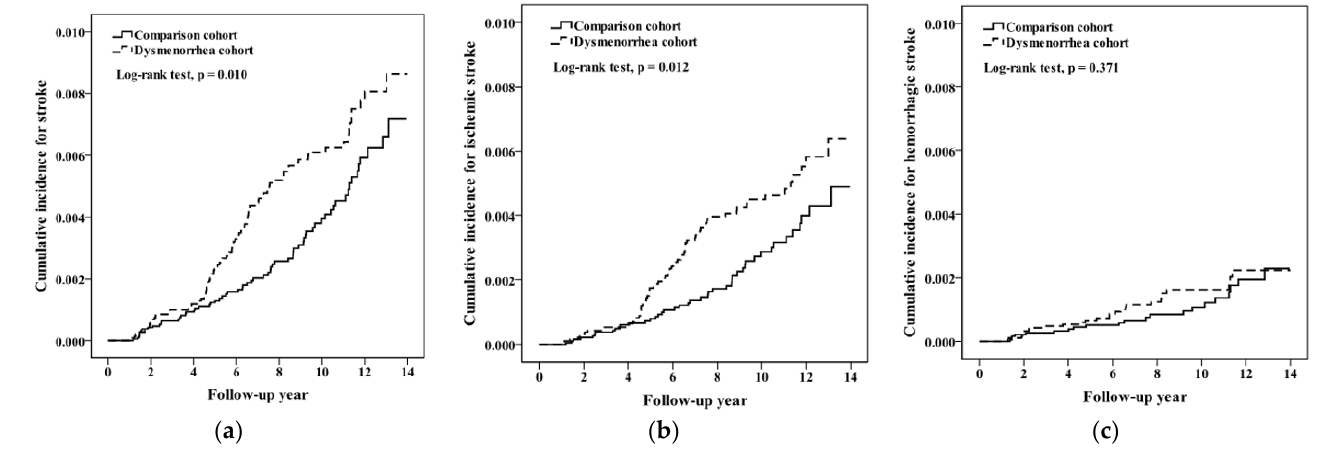
Figure 2. Kaplan–Meier method estimated cumulative incidence for ( a ) stroke, ( b ) ischemic stroke, and ( c ) hemorrhagic stroke in dysmenorrhea and comparison cohorts.